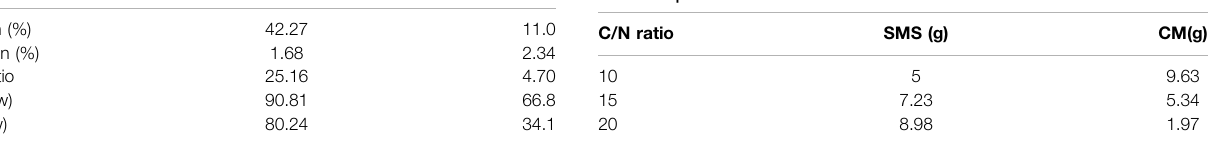
TABLE 1 | Chemical composition of SMS